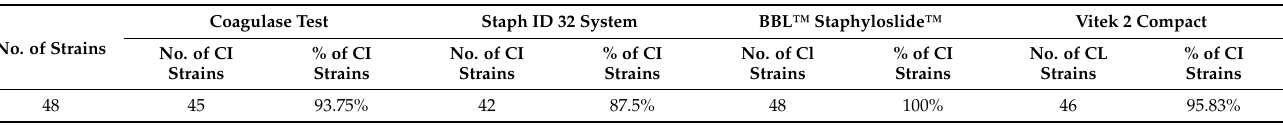
Table 2. Comparison between different phenotypic techniques used for recognition of S. aureus recovered from clinical